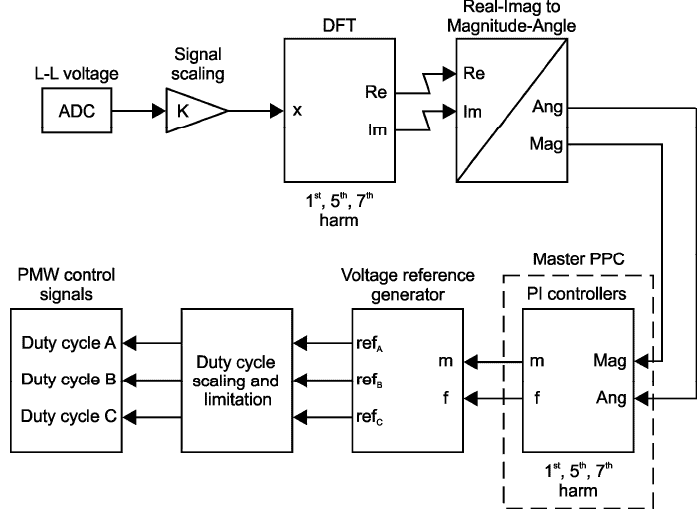
Figure 2. Simulink model for driving three-phase IGBT inverter.